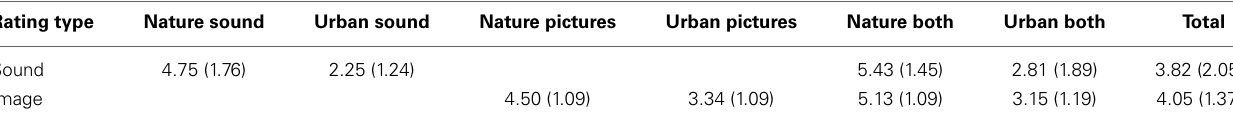
Table 1 | Ratings of relaxation for sounds and for